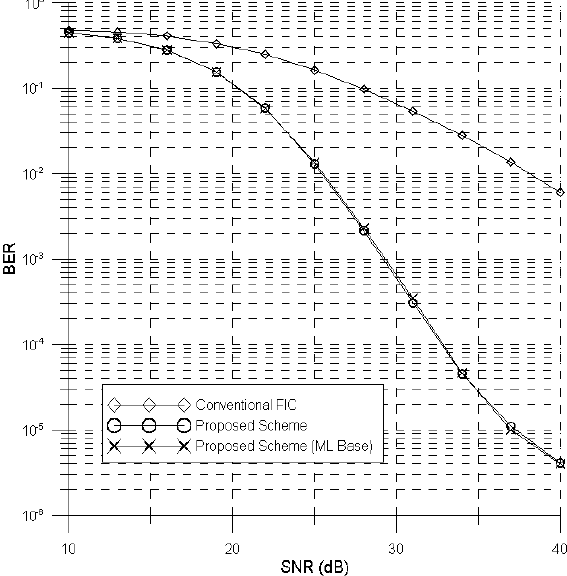
Figure 3. The BER performances for the conventional FIC and the proposed scheme. BER: bit error rate, FIC: full interference cancellation.